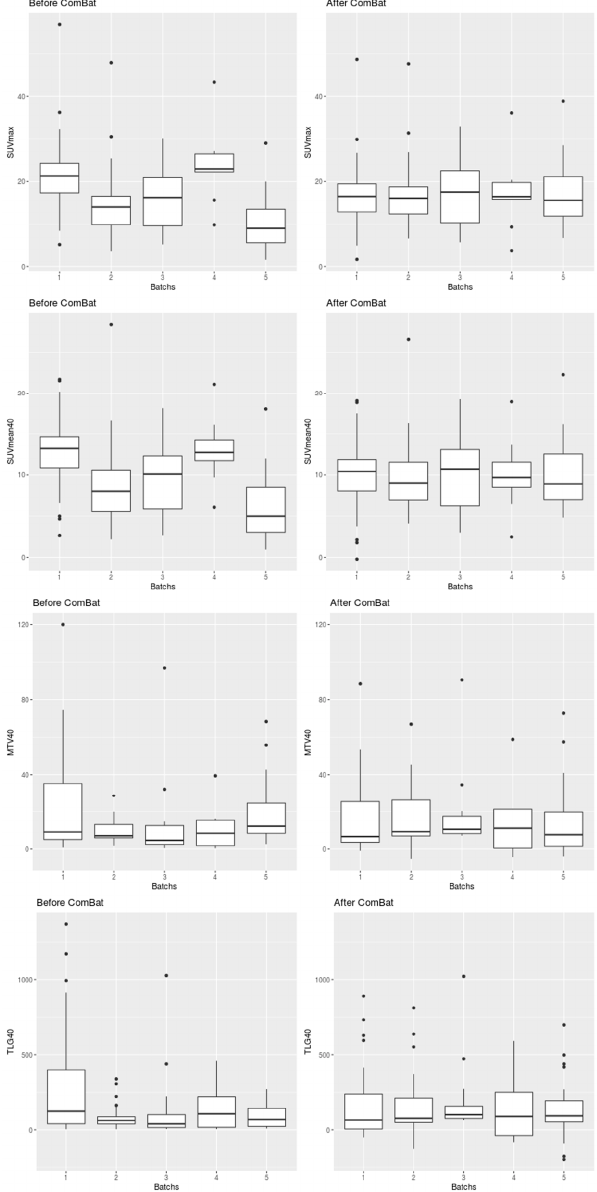
Figure A1. Boxplots showing distributions of PET parameters according to the different tomographs before and after ComBat harmonization. Batches: 1= fully hybrid 3 T PET/MRI system (SIGNA PET/MRI; GE Healthcare); 2= Discovery STE (GE Healthcare); 3= Discovery ST (GE Healthcare); 4= Discovery 690 (GE Healthcare); 5= Gemini–GXL (Philips Medical Systems); SUV: standardized uptake value; MTV: metabolic tumour volume; TLG: total lesion glycolysis.